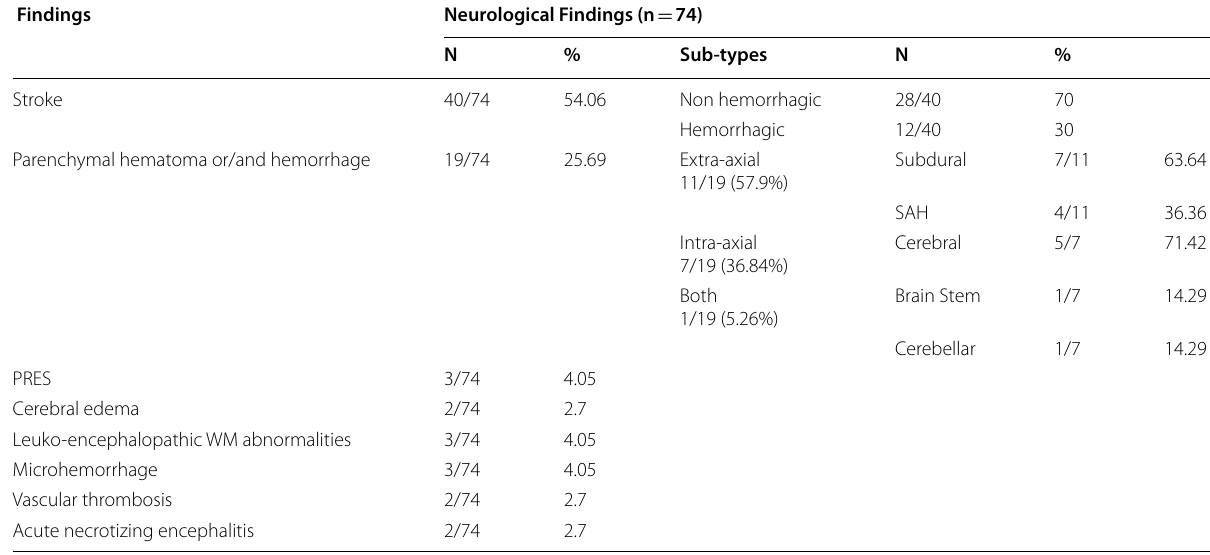
Table 2 Classification of neurological findings